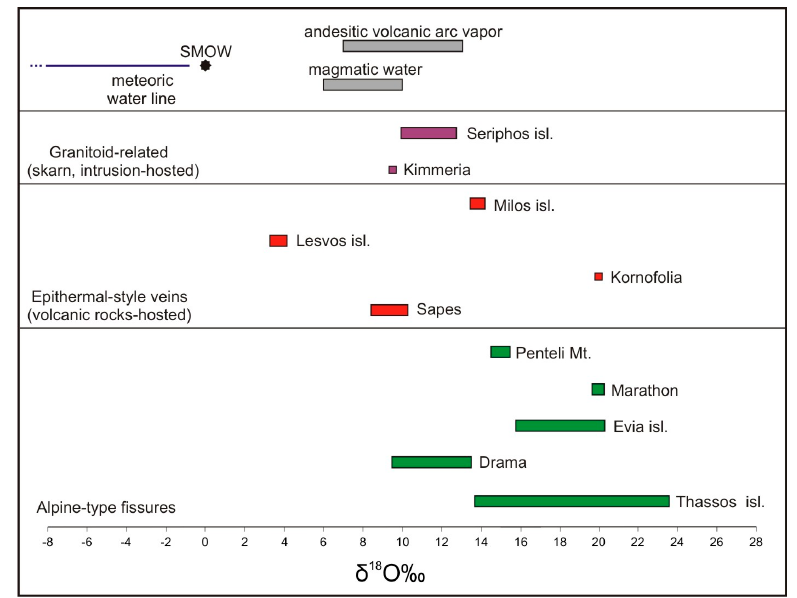
Figure 9. δ 18 O values of quartz varieties from Greece. The values for magmatic water and andesitic volcanic arc vapor are from Taylor [54] and Giggenbach [55], respectively. Table 3. Oxygen isotope composition of quartz from various geological settings in Greece ( δ values in % (cid:24) relative to